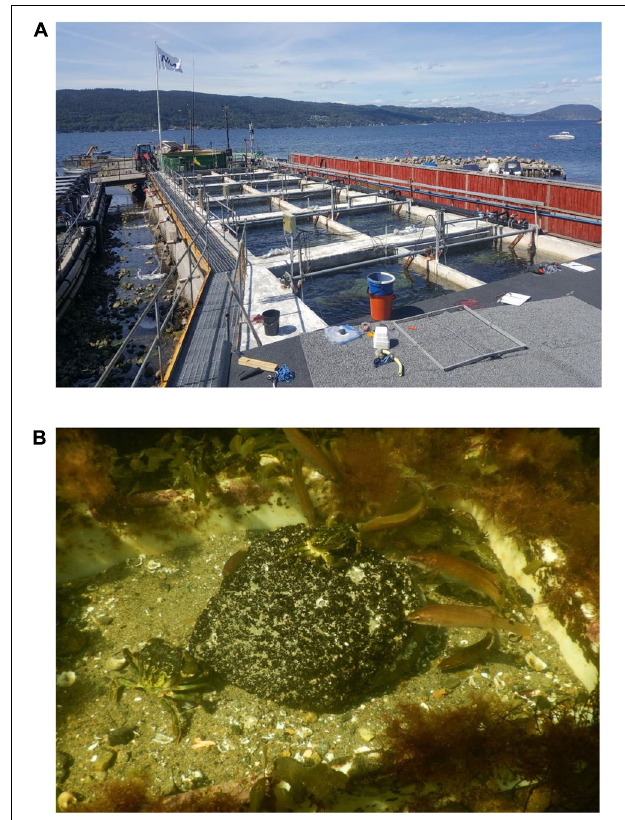
FIGURE 1 | Images showing an overview of the 12 mesocosms at NIVAs Research Station at the Oslofjord (A) , and an example of green crabs and goldsinny wrasses attacking a stone with juvenile mussels (B)